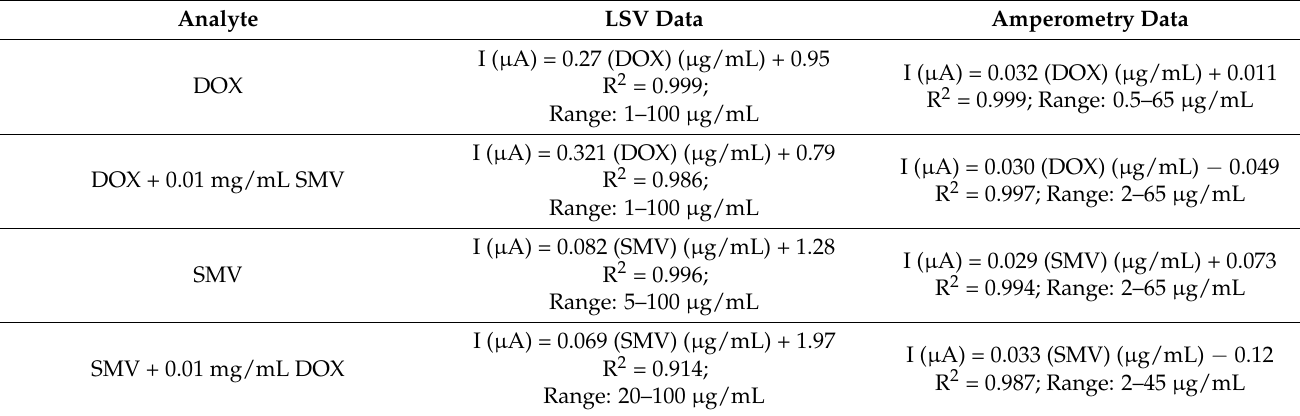
Table 2. Equations of the calibration curves for DOX and SMV alone and in the presence of each other, using LSV and Amperometry.